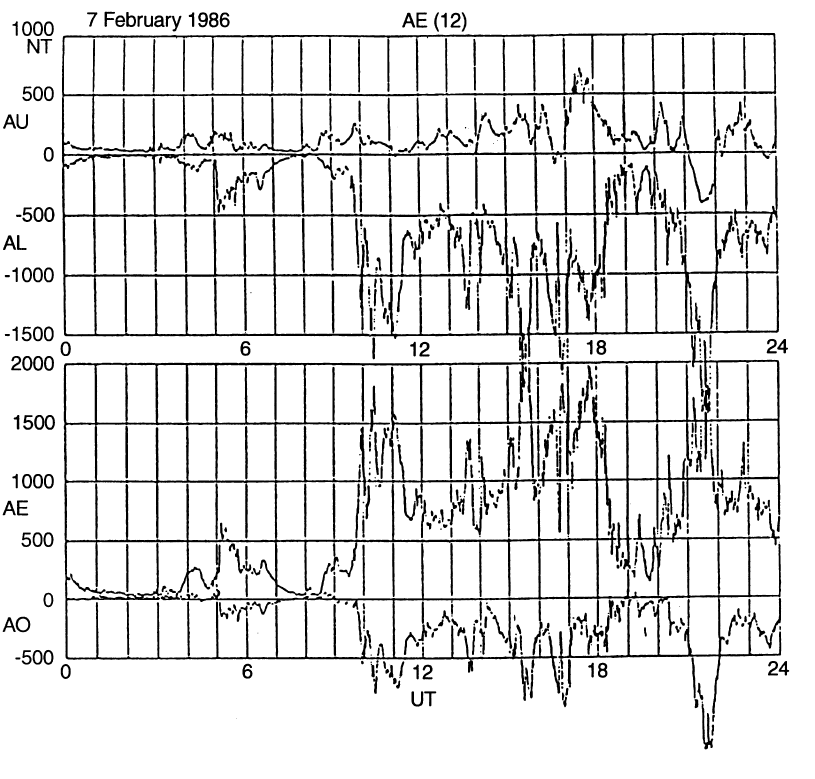
Fig. 3. Aurol electrojet indices of February